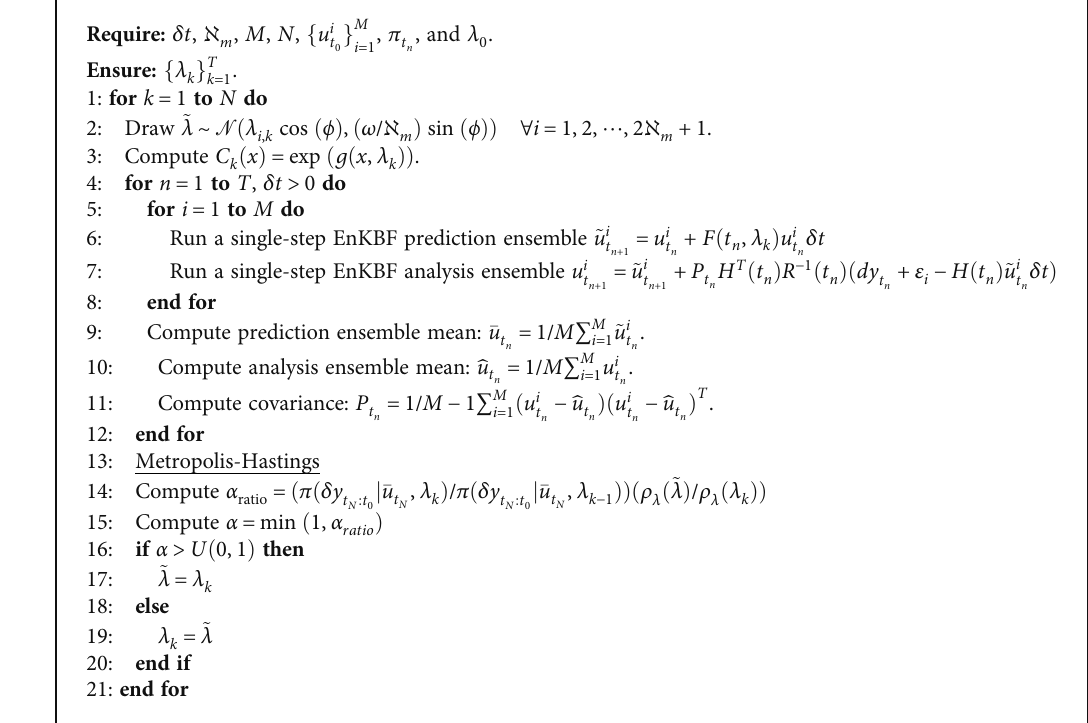
Algorithm 3: EnKBF likelihood with